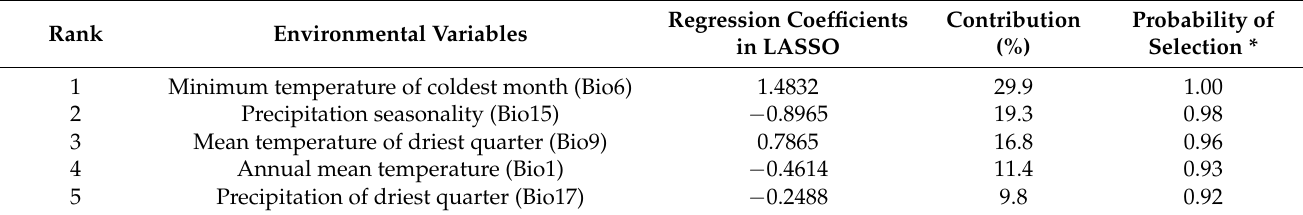
Table 2. Ranking of the importance of environmental variables for predicting the distribution of Dendroctonus armandi.